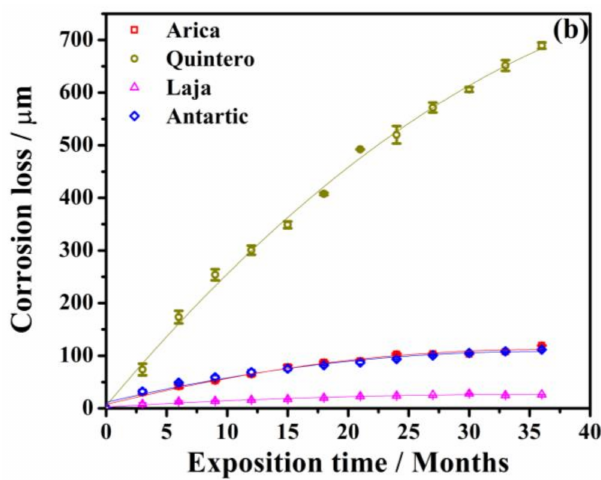
Figure 3. ( a ) Corrosion rate; ( b ) corrosion loss as a function of exposure time at different stations. The data were evaluated and averaged from